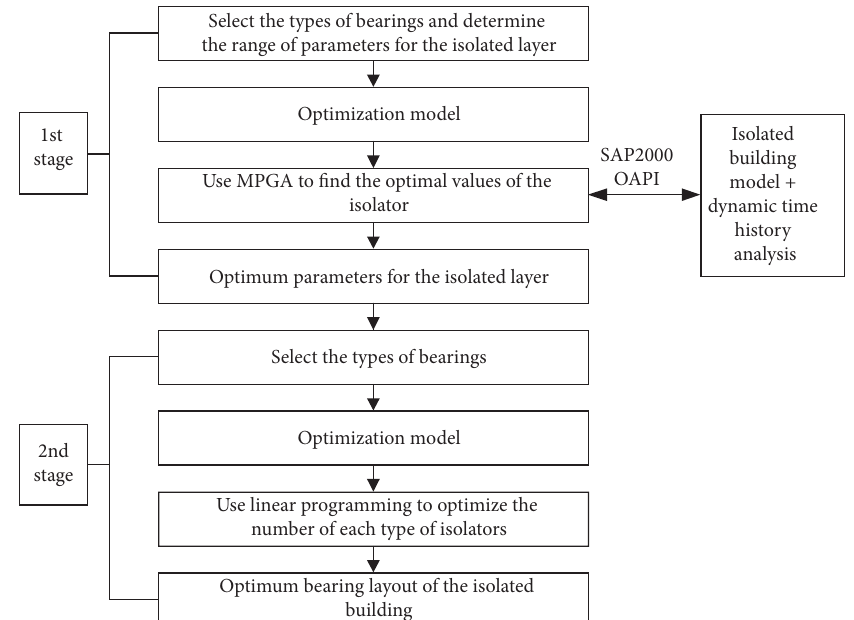
Figure 1: Two-stage optimization method for isolation bearing layout.